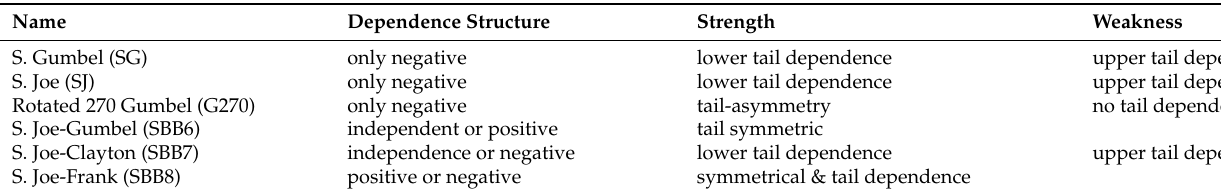
Table 9. Characteristic of copula functions.